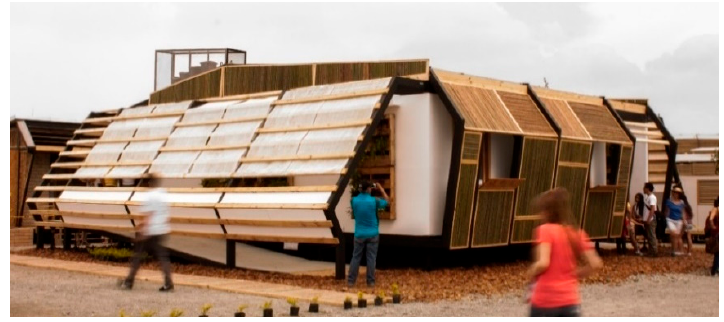
Figure 15. Photo of the south-east facade.